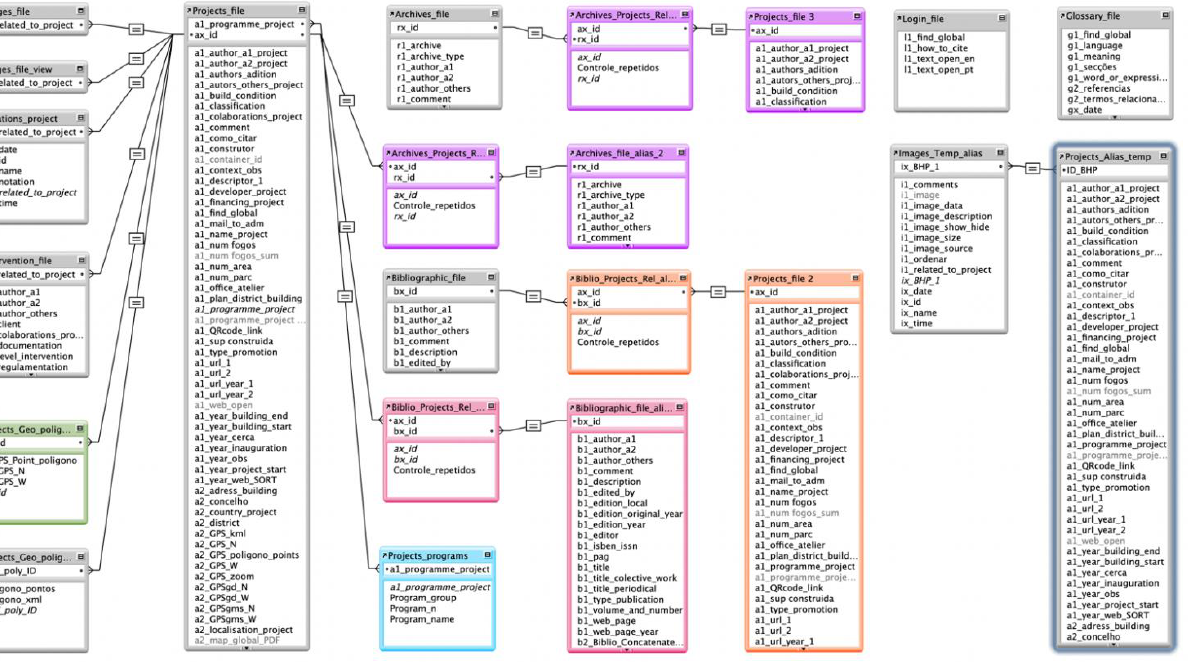
Figure A1. Data flow diagram of MdH database. Source: MdH database, 2019.